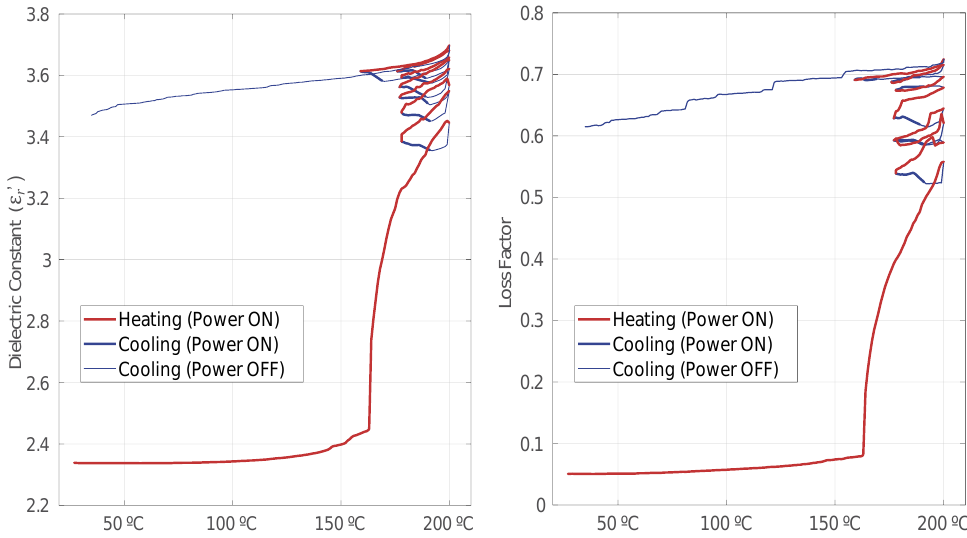
Figure 6. Relative electric permittivity behavior versus temperature with the power on – off cycles discrimination for Test 6. Table 2. Fitting curve parameters for the dielectric constant model described by Equation (5). Test